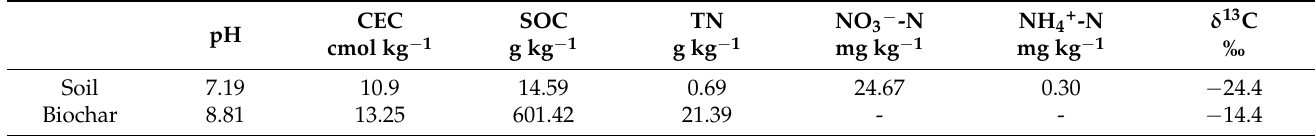
Table 1. Physicochemical properties of soil and